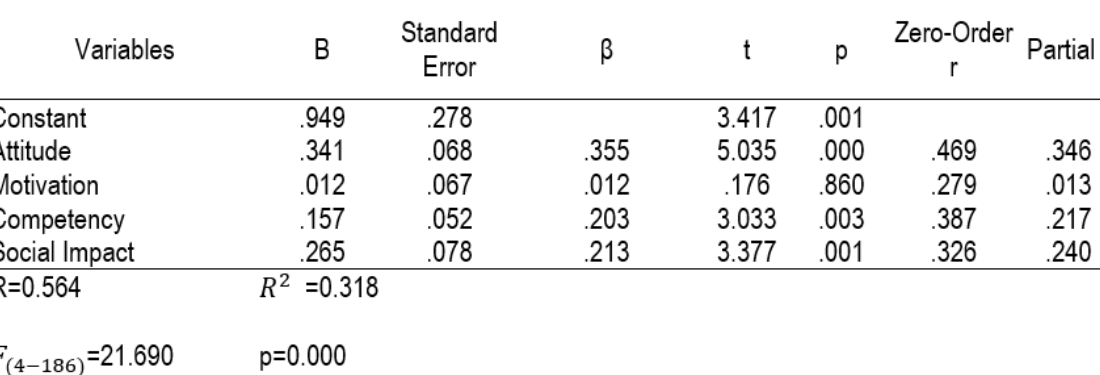
Multiple Regression Findings of Frequency of Using Mobile Learning Technology on Learning